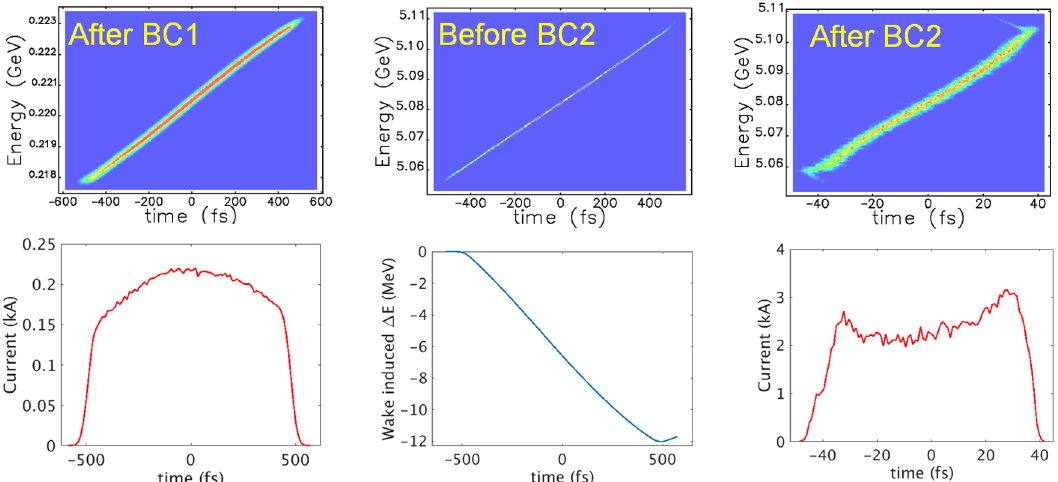
FIG. 3. Simulation examples of the collimated beam. BC1 collimator is used to truncate the bunch charge from 250 pC to 180 pC. Left column: electron beam longitudinal phase space and current profile after BC1 chicane. Middle column: longitudinal phase space before BC2 chicane and L2-linac wake induced energy change. Right column: longitudinal phase space and current profile after BC2 chicane.